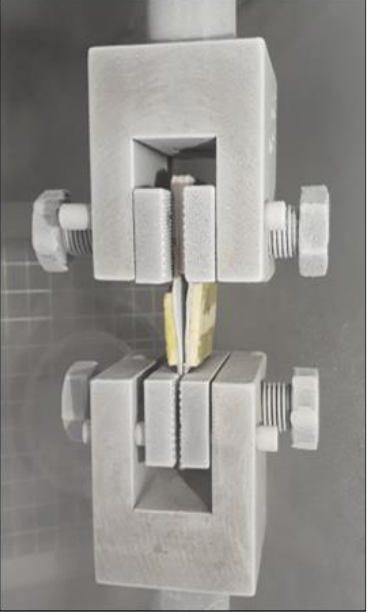
Figure 8. Photograph of the UTM apparatus used for the mechanical tests.